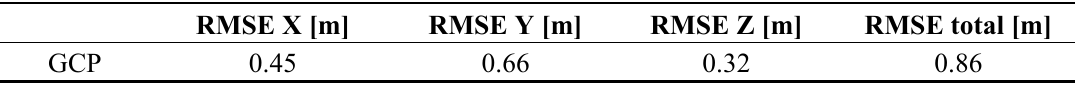
the bias correction of the rational polynomial coefficients (RPCs) of the WorldView-2 satellite